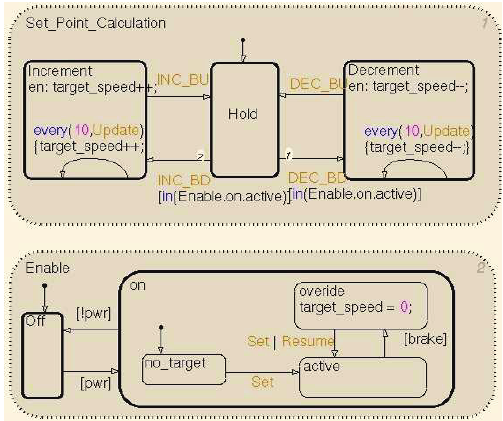
Fig. 2. Simulink stateflow model of a cruise control.